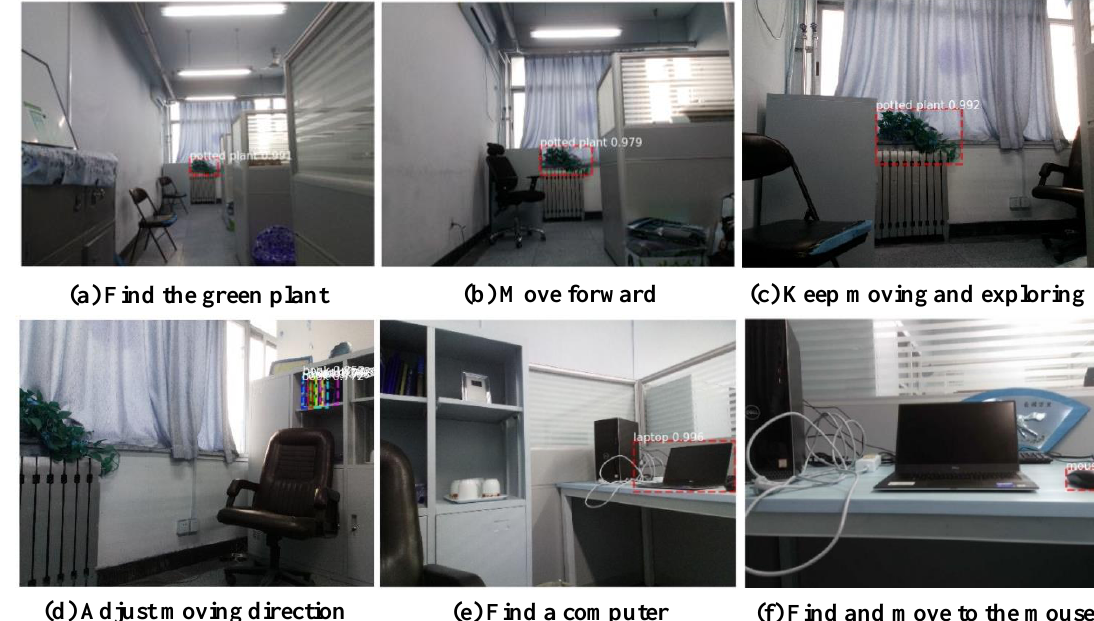
Figure 14. Experiment in real scenario.